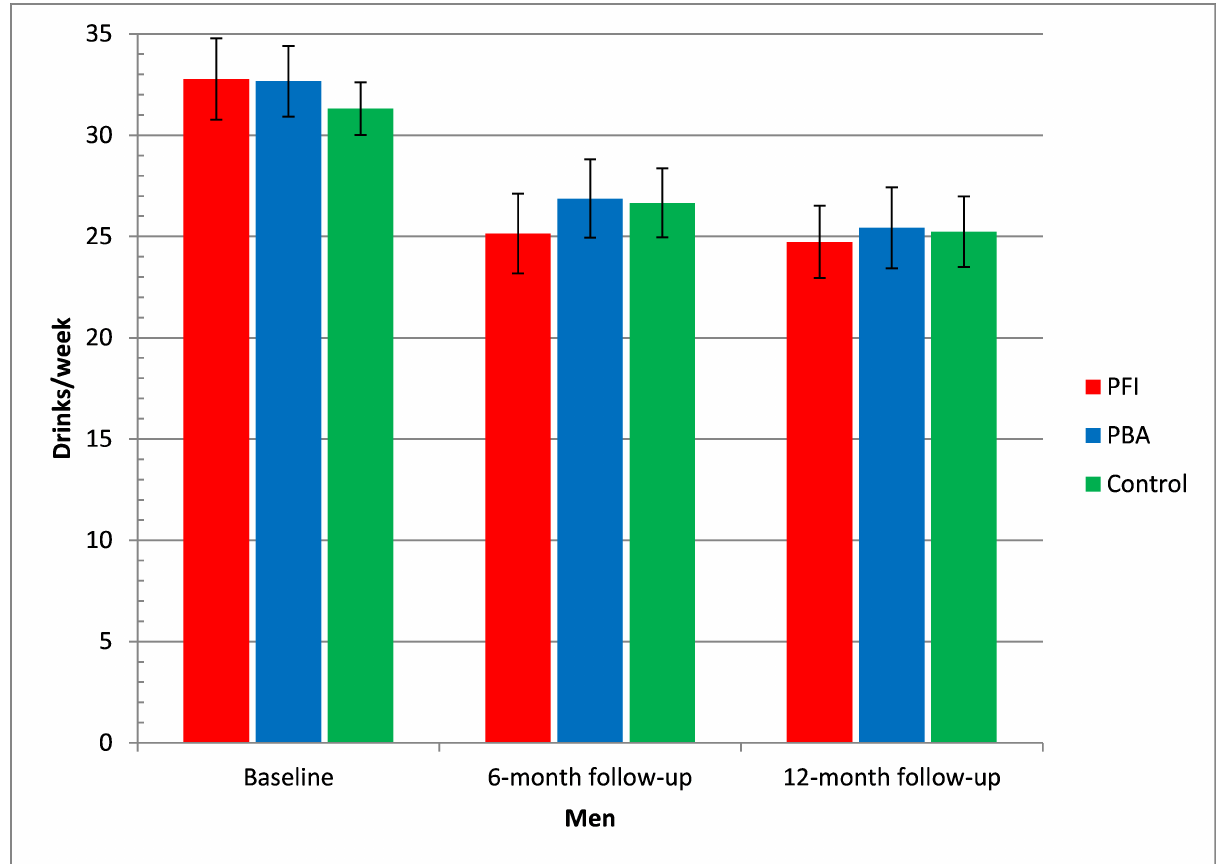
Figure 6. Alcohol consumption at baseline and at 6- and 12-month follow-ups for men based on multiple imputation. Error bars indicate 95% confidence interval. Drinks/week = mean number of standard drinks in a typical week, PBA = Internet-based personalized brief advice intervention, PFI = Internet-based brief personalized feedback